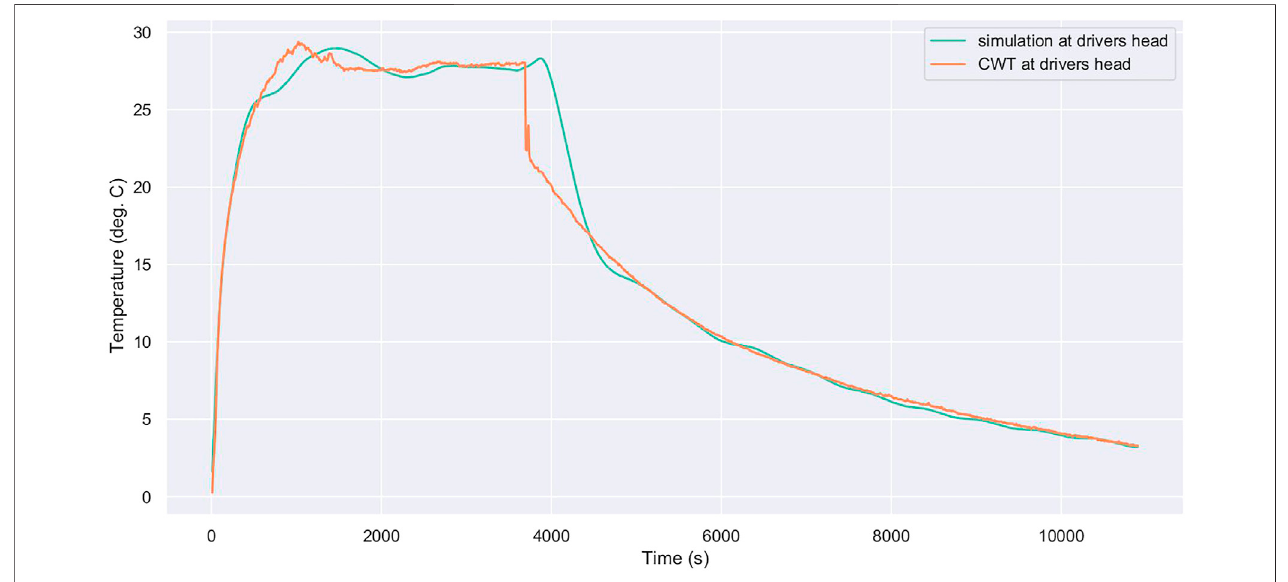
Frontiers in Mechanical Engineering |